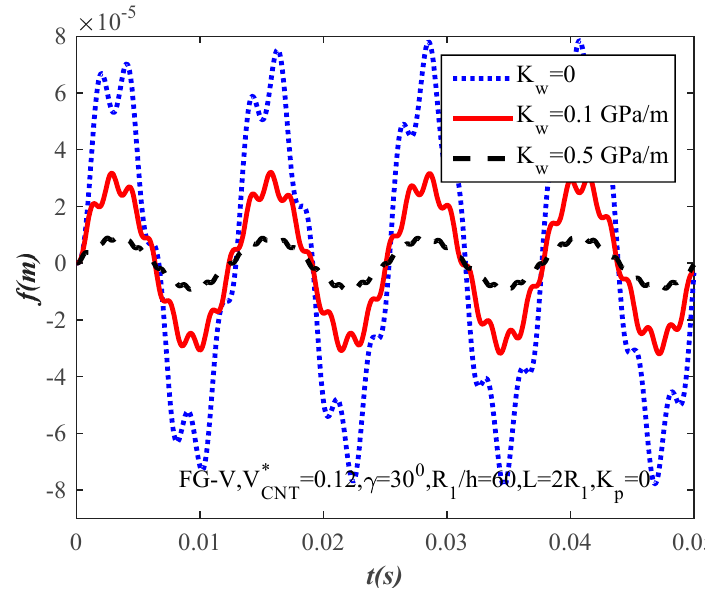
K on the dynamic response of the FG-CNTRC w